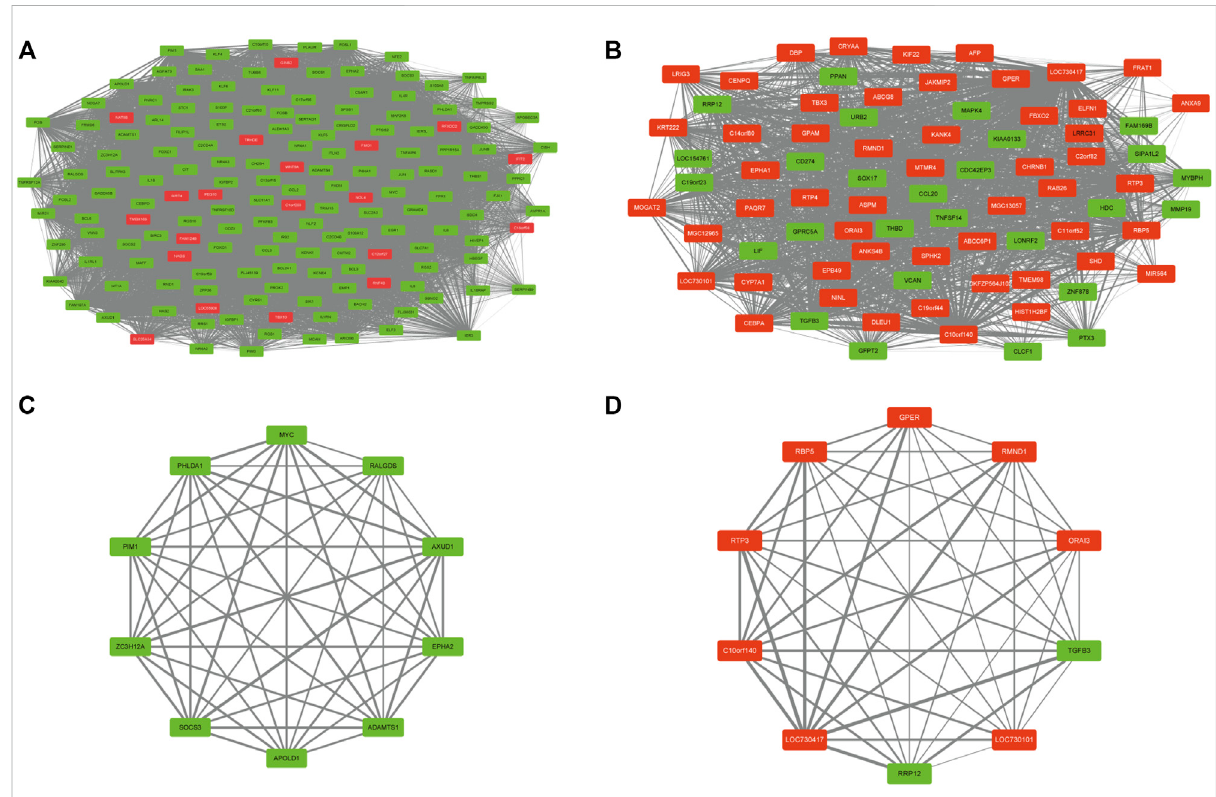
FIGURE 6 DEG co-expression network and hub genes. (A,B) DEG co-expression networks for brown andyellowmodules. (C,D) hubgenes for brownand yellow